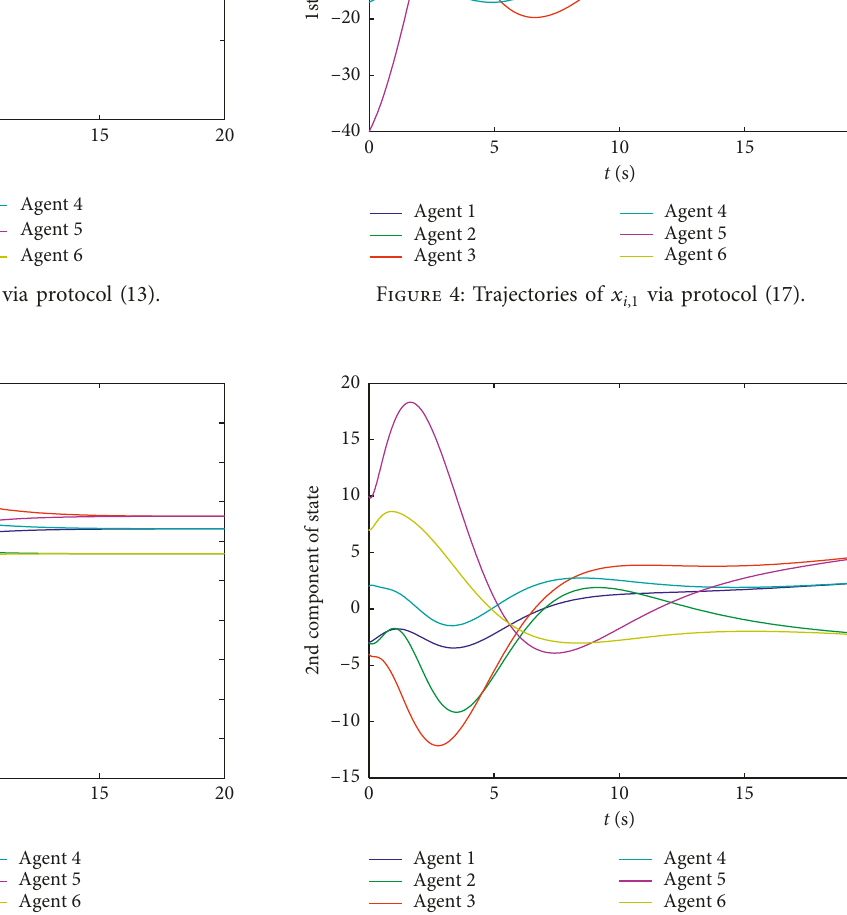
Figure 3: Trajectories of x